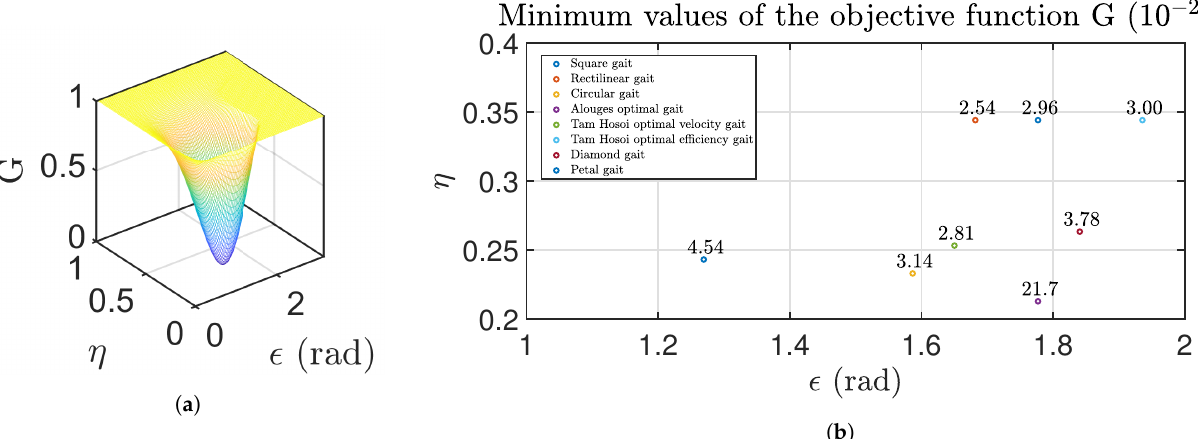
Figure 9. Results from optimal objective function: ( a ) 3D plot of the objective function applying the square gait, ( b ) minimum values of the objective function with their corresponding gait amplitude ( (cid:101) ) and relation between lengths of the links ( η ). Table 3. Optimal values of gait amplitude ( (cid:101) ) and relation between lengths of the links ( η ) for minimum values of the objective function. The data are sorted in order of increasing function